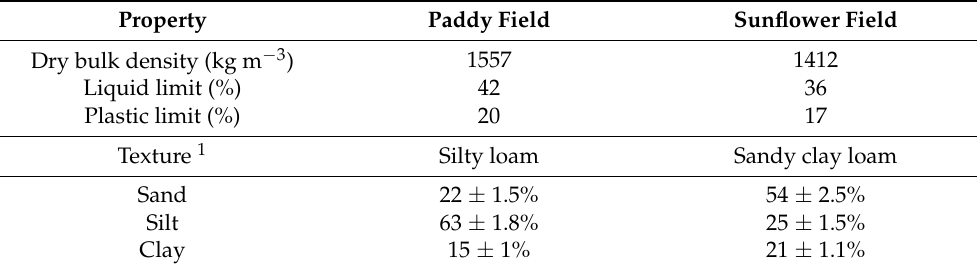
Table 2. Experimental soil